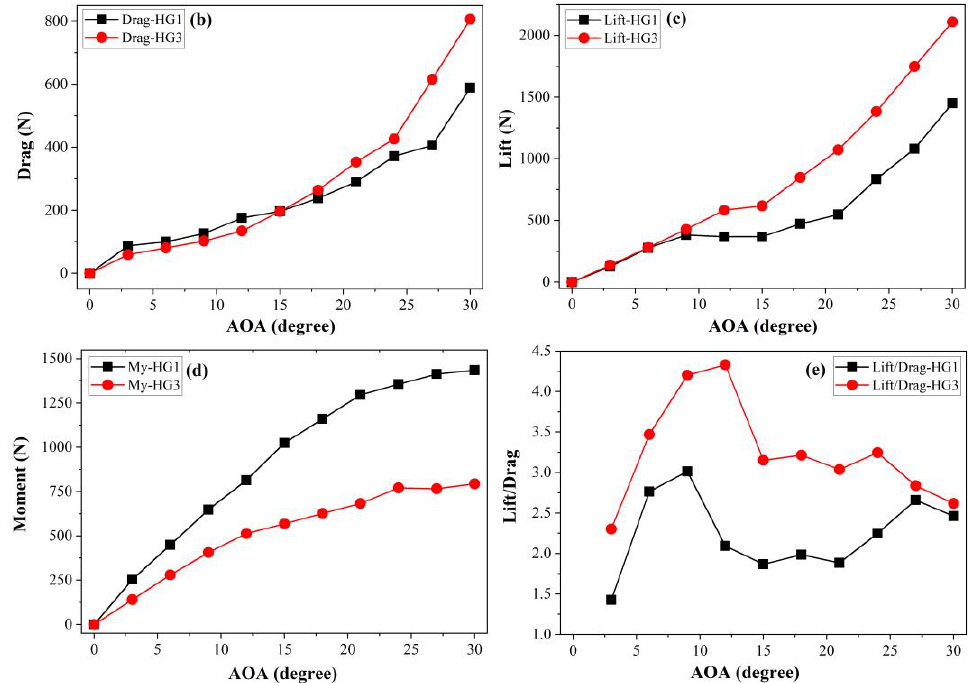
Figure 7. ( a ) Projection area (along upstream area) of HG1 on the 𝑦𝑜𝑧 plane and simulated varia- tions of the drag, lift, and moment and drag-to-lift ratio as a function of the angle of attack (AOA). ( b ) drag, ( c ) lift, ( d ) moment, ( e ) lift to drag ratio.